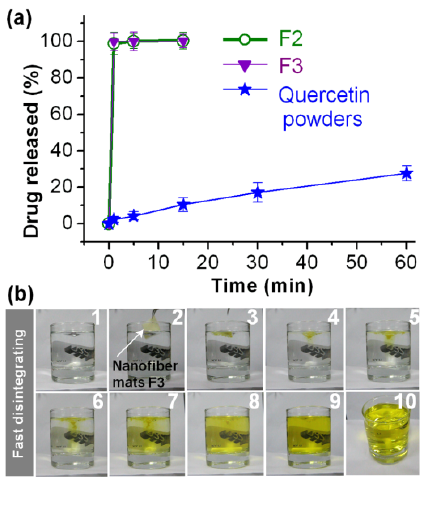
Figure 7. In vitro dissolution tests: ( a ) In vitro drug release profiles of the quercetin-loaded nanocomposites; ( b ) Photographs of the disintegrating process of nanofibres F3. The fast-dissolving process is shown in sequence from 1 to